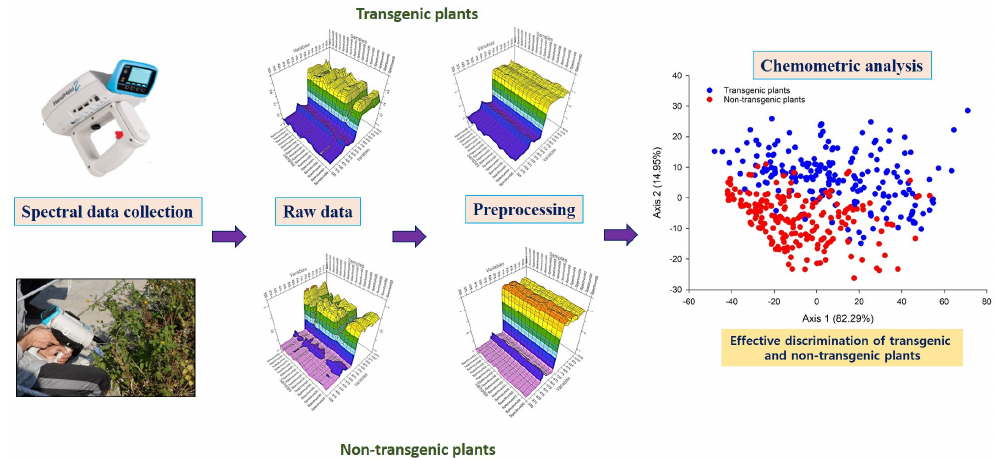
Figure 3. A typical example for application of NIRS with chemometrics on the detection of transgenic